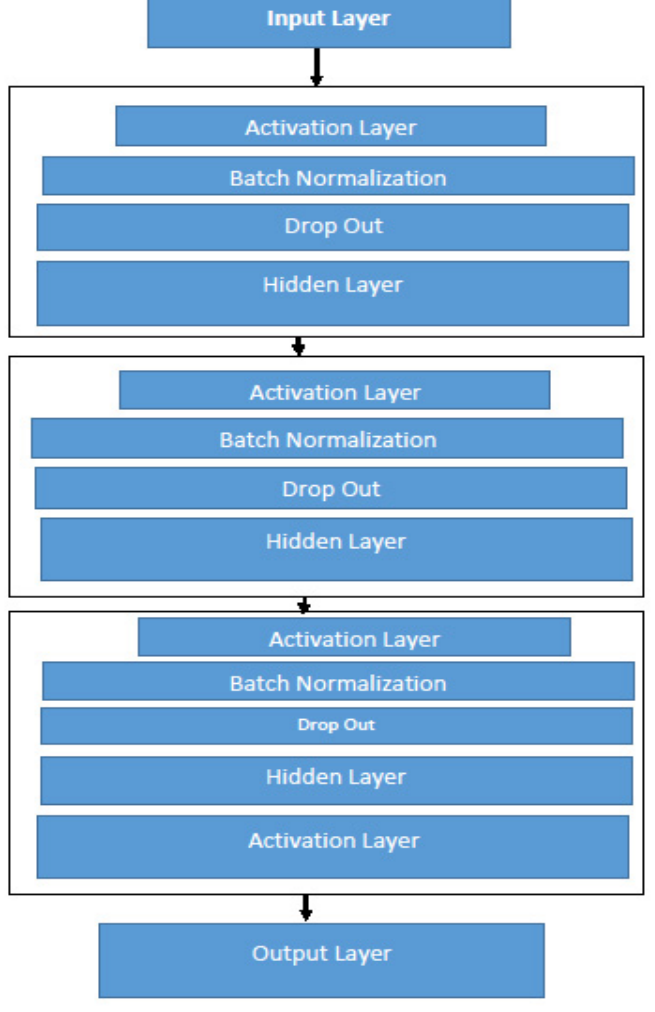
Figure 2. Proposed deep learning